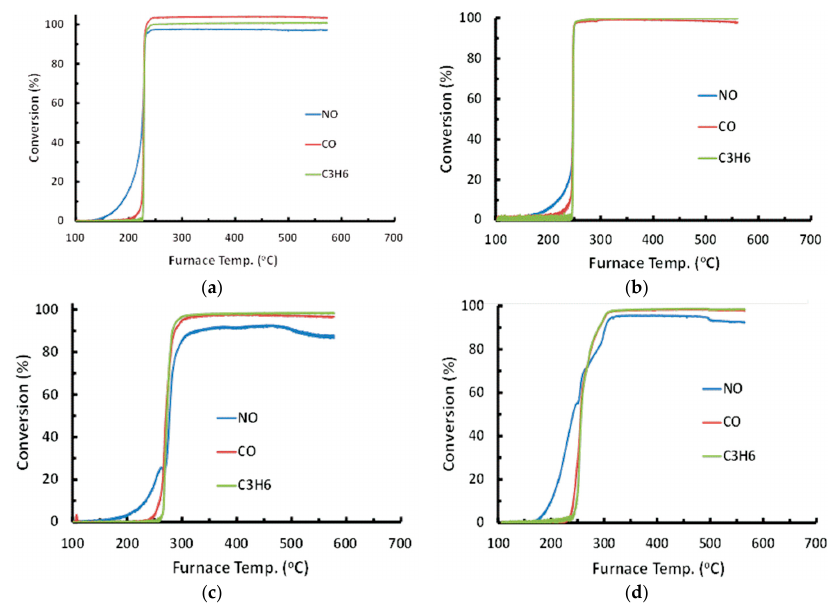
Figure 8. Light off curves of the TWC inlet samples for ( a ) FUL_AR, ( b ) FUL_NA, ( c ) FUL_ZDDP, and ( d ) FUL_IL with a ramp rate of 2 °C/min; furnace temperature is within 5 °C of the inlet gas temperature.